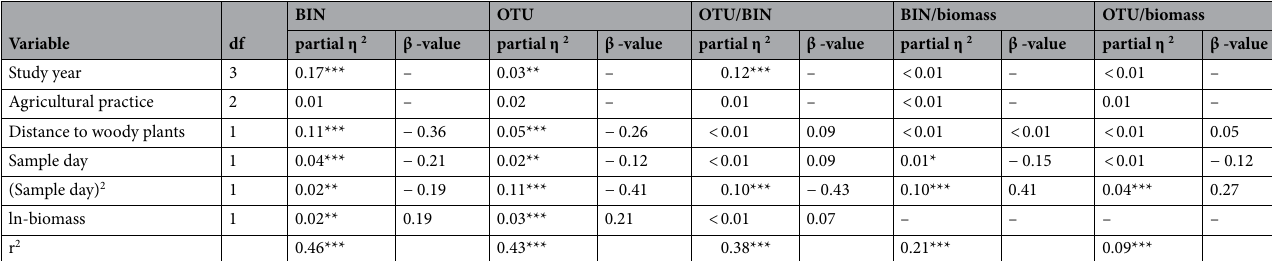
Table 3. Nested general linear modelling (study year nested within agricultural practice) identified major drivers in the number of BINs and OTUs. Given are partial η 2 - and β -values and the coefficient of determination r 2 of the whole model. N = 340. df degrees of freedom. Parametric significances: *P < 0.05, **P < 0.01, ***P <